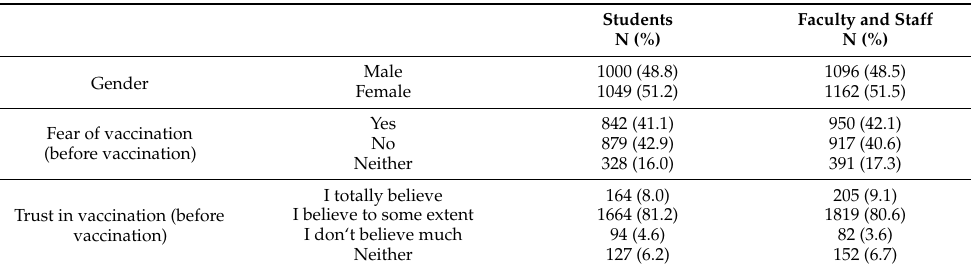
Table 2. Comparison of students and faculty and staff (fear and trust in vaccination).